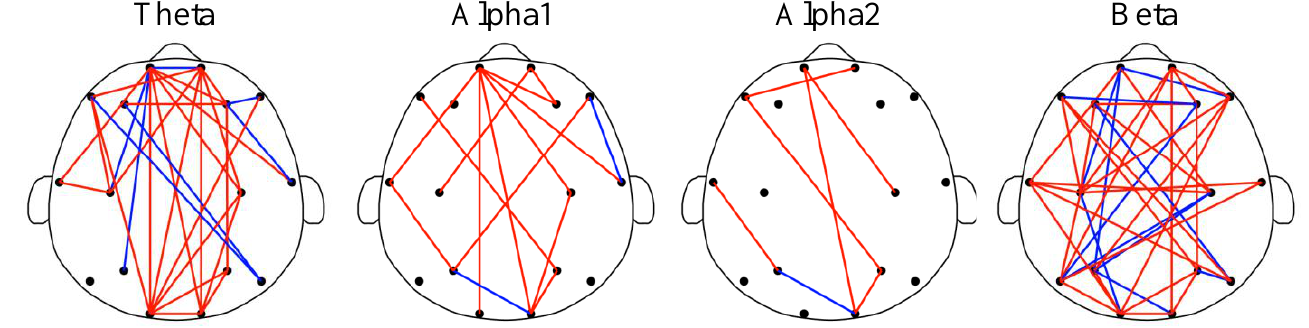
Figure 3. Brain functional network of theta, alpha1, alpha2, and beta rhythms. In the brain functional networks, the red edge means the PLI value of GAD is lower than that of HC. Meanwhile, the blue edge represents the PLI value of GAD is higher than that of HC.